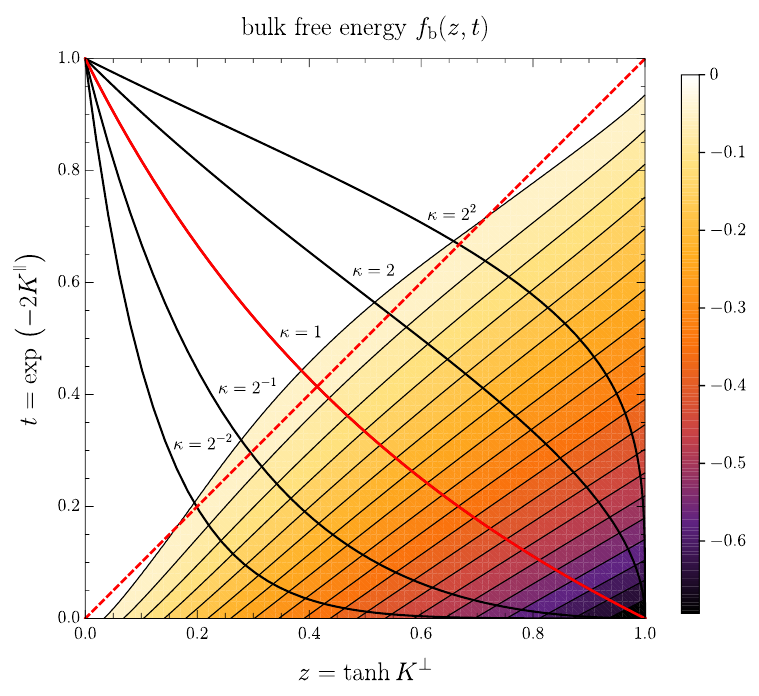
( z , t ) . The dashed line marks criticality for ar- Figure 4: Bulk free energy density f b bitrary anisotropy κ = K ⊥ / K (cid:107) . For fixed anisotropy the two couplings are connected by t = ( z ∗ ) κ , see (3.21), and the black lines mark the run of the corresponding curve, where the isotropic case κ = 1 is shown in